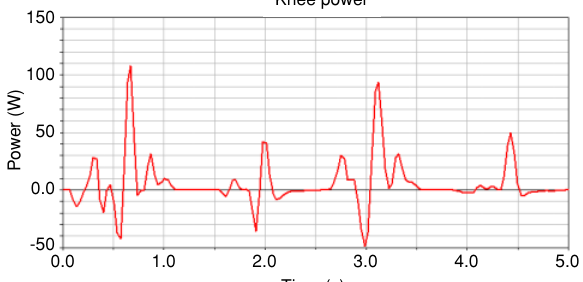
Figure 19 Inner exoskeleton with the encoder bracket. Table 3 Allowable angles of the joint